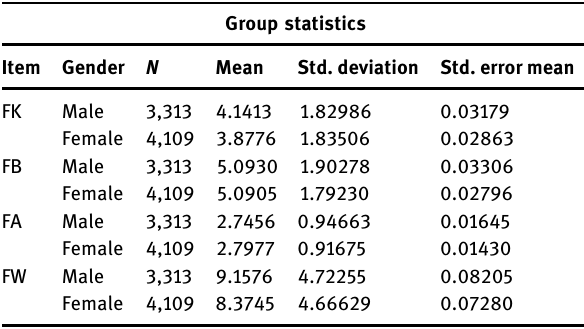
Table 7: Descriptive statistics for items in H1 to H4, regarding gender for all countries